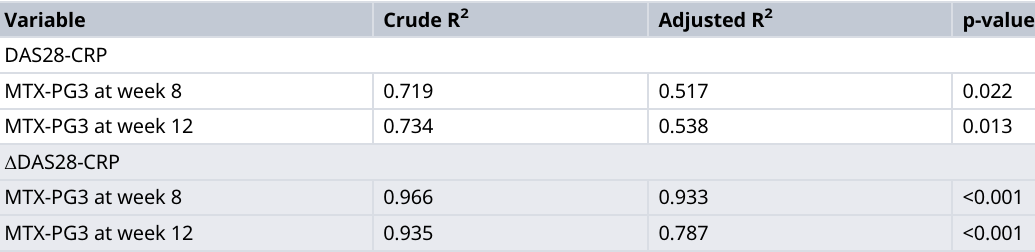
Table 3. Multivariate analysis showing the correlation of MTX-PG3 level with DAS28-CRP and Δ DAS28-CRP.